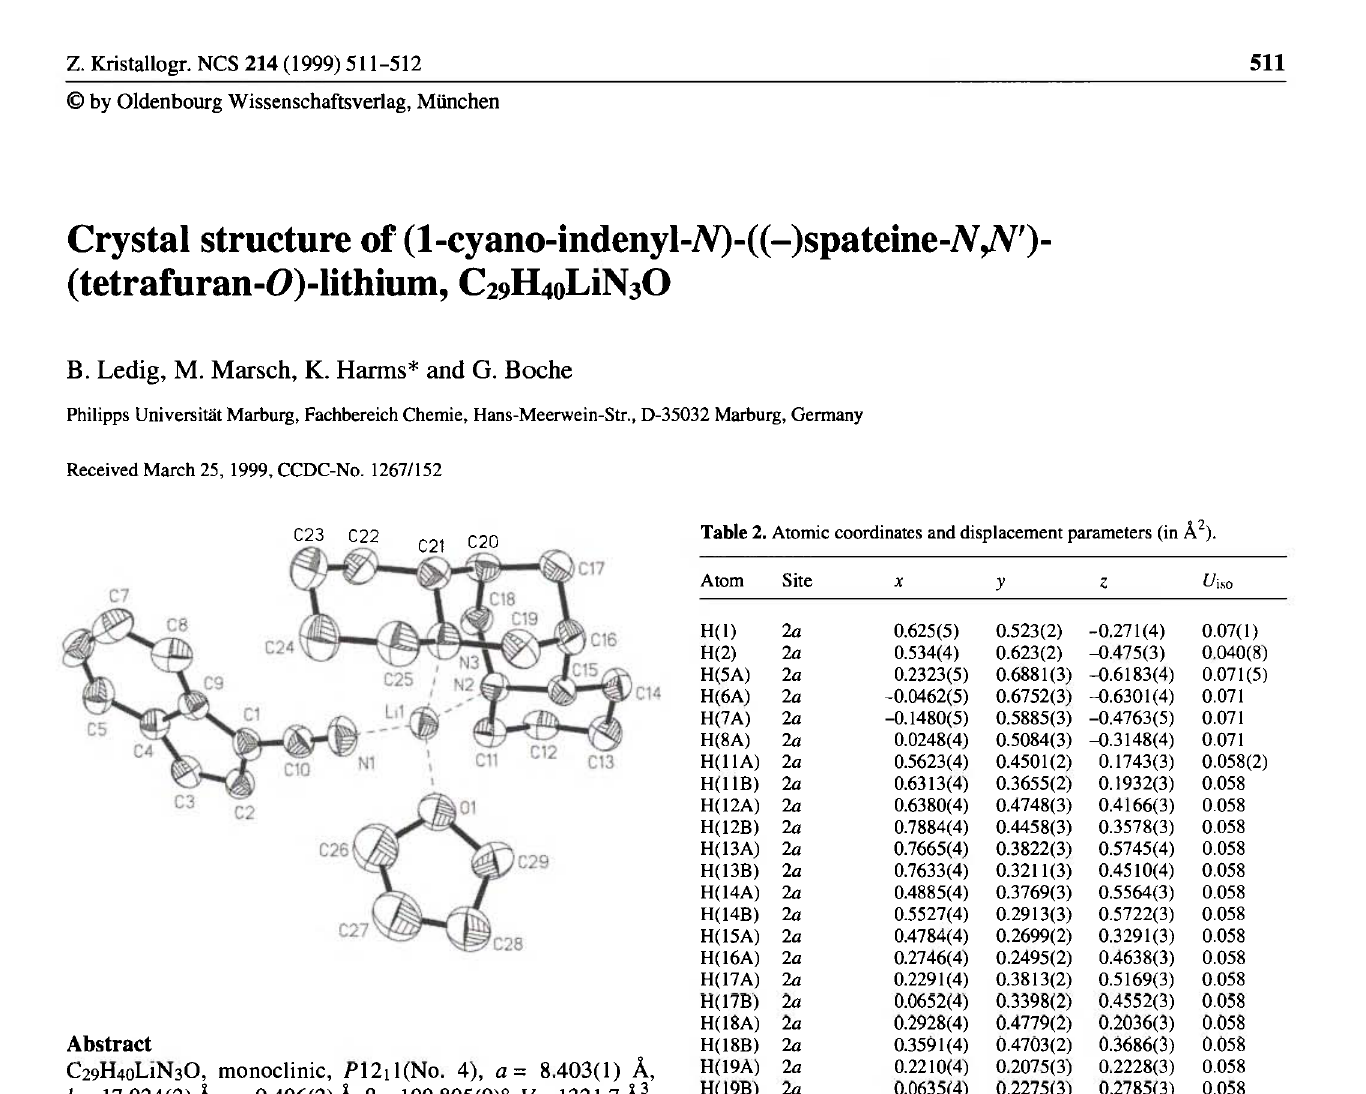
Table 1. Data collection and handling.